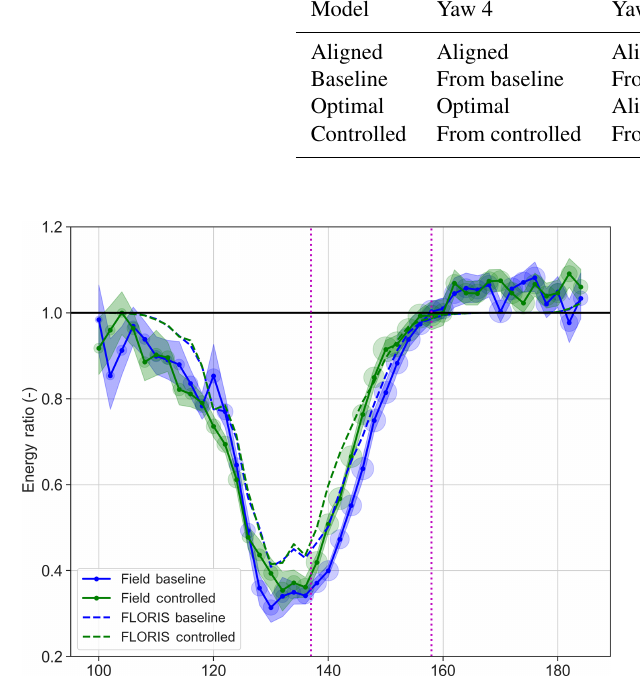
Figure 12. Change in the energy ratio of T3 from field data. Expec- tations from FLORIS using the actually achieved controlled offsets (controlled − baseline) and optimal (optimal − aligned) are shown to indicate comparison with expectations given control values and what is optimally